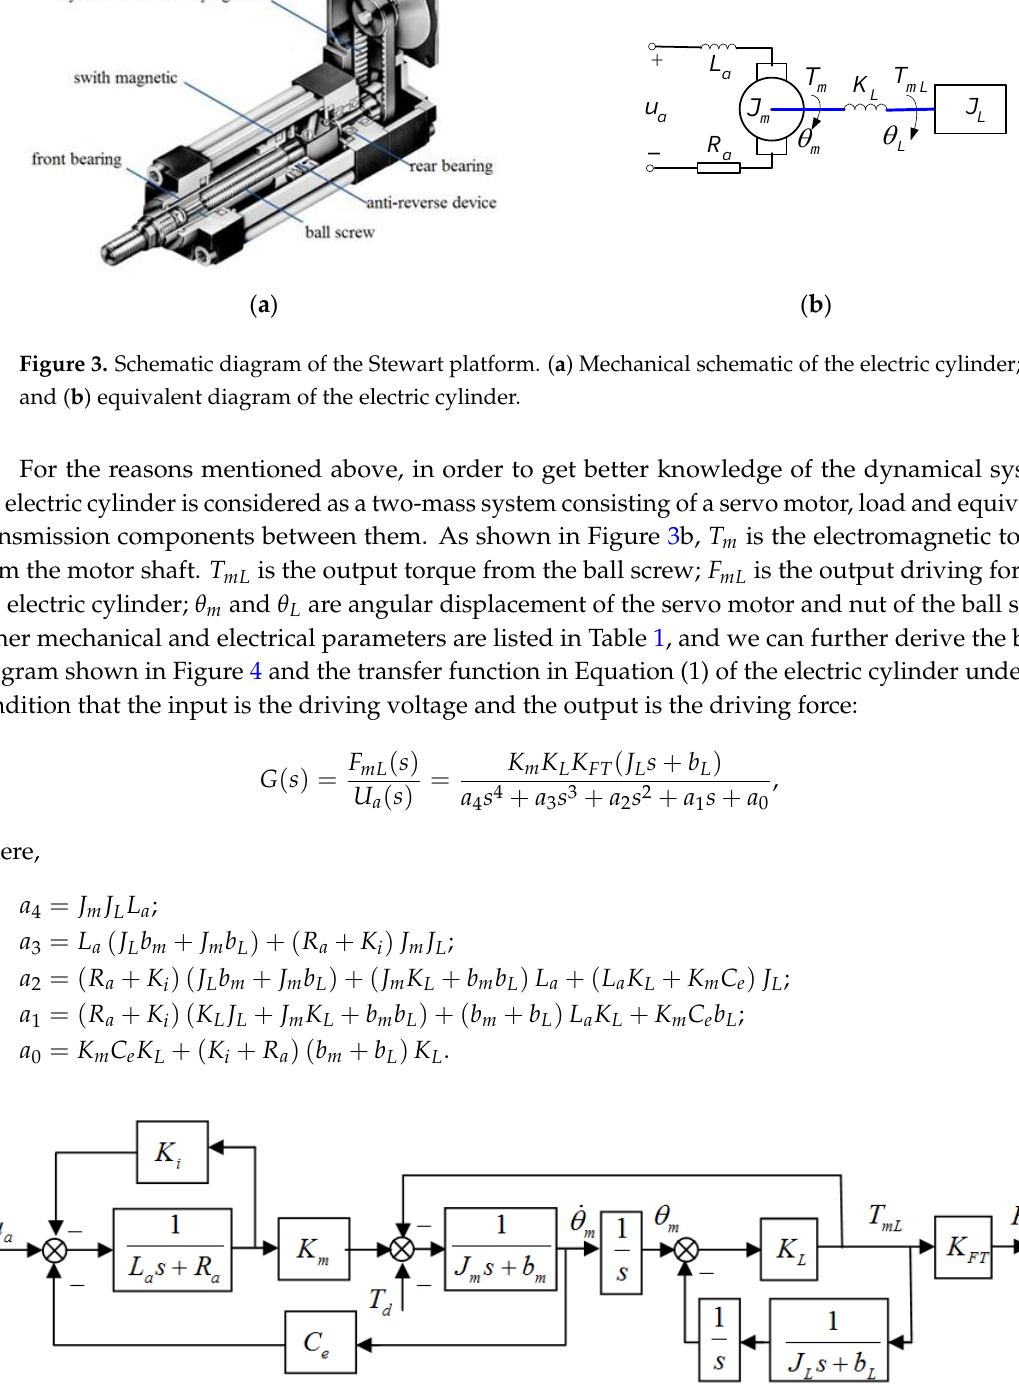
Figure 4. Block diagram of the electric cylinder in the Stewart platform.